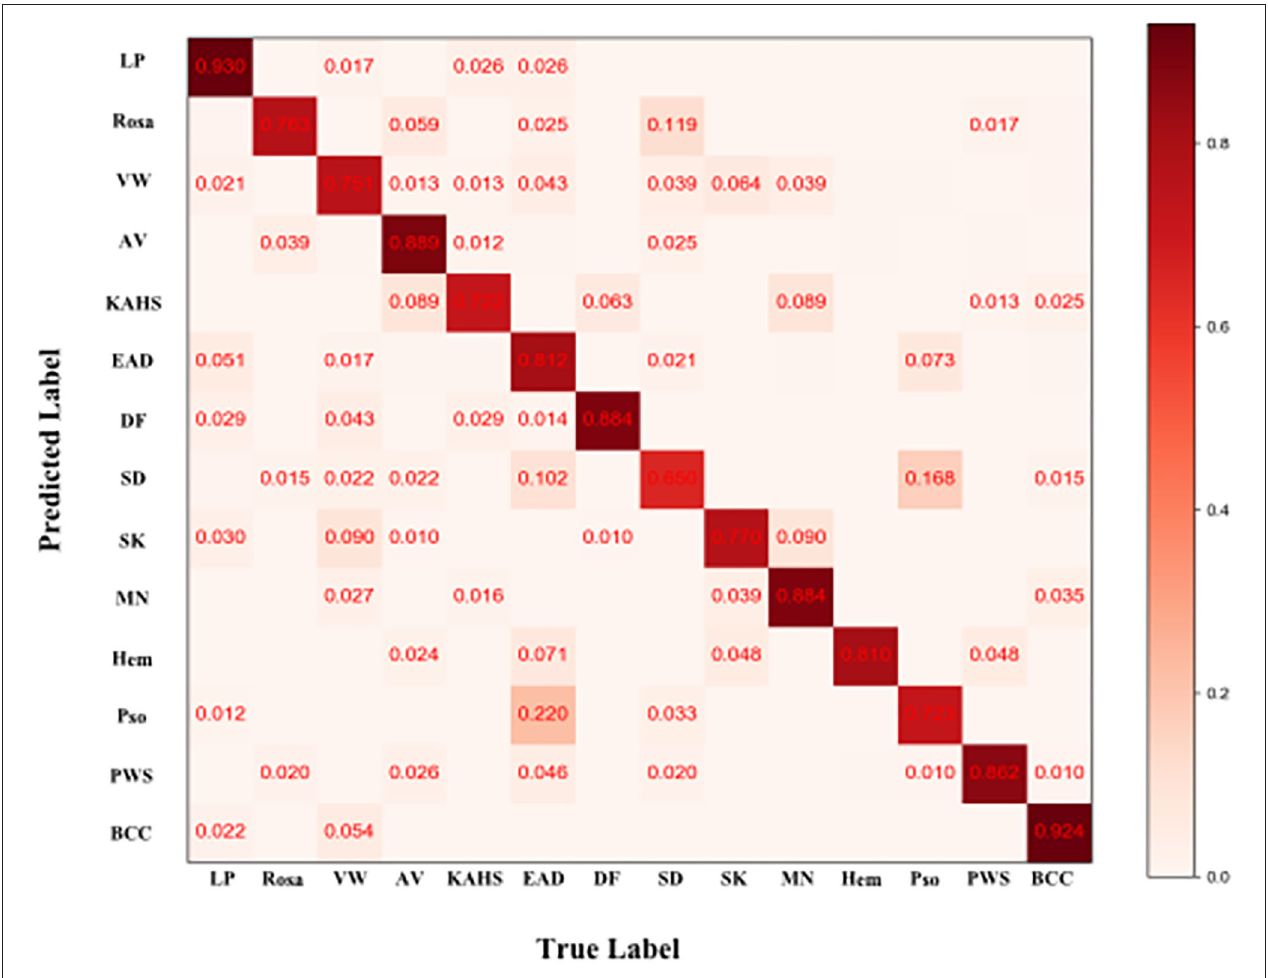
FIGURE 6 | Confusion matrix of the classification result. Element (i, j) of each confusion matrix represents the empirical probability of predicting class i given that the ground truth was class j, with i and j referencing classes from Table 1 . Light red means low percentage and deep red represents high